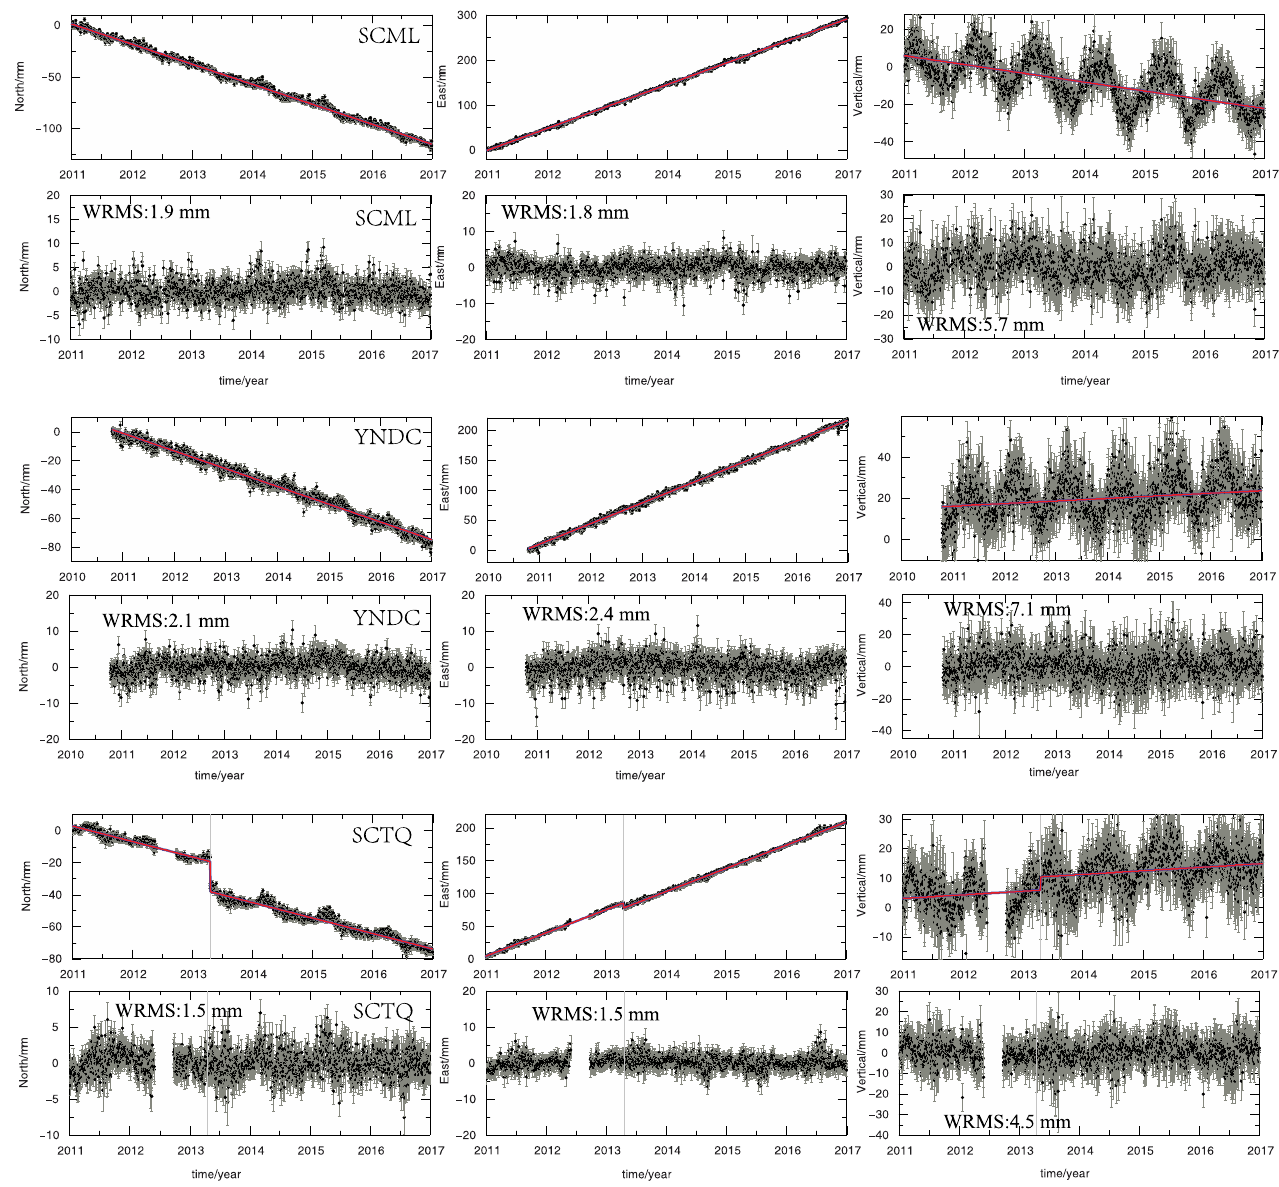
Figure 4. Time series and errors of three GNSS continuous sites: SCML (first two rows), YNDC (third and fourth rows), SCTQ (fifth and sixth rows). Others are the same as Figure 3.